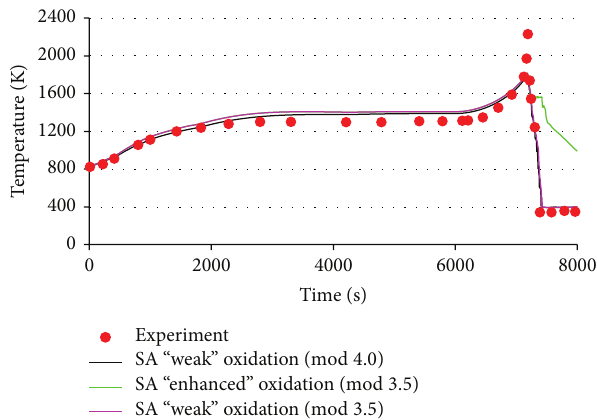
Figure 13: QUENCH-06 test calculation using RELAP/SCDAPSIM mod 4.0 and mod 3.5. Fuel rod imitator cladding outer surface temperature in inner ring of bundle at 750 mm height.